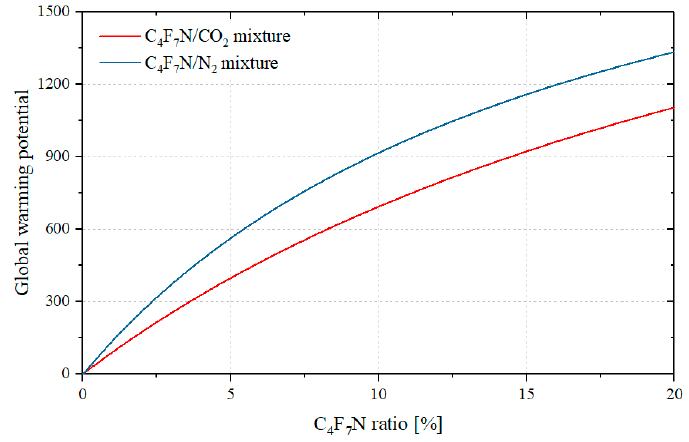
Figure 7. Global warming potential of g3 gas mixture.